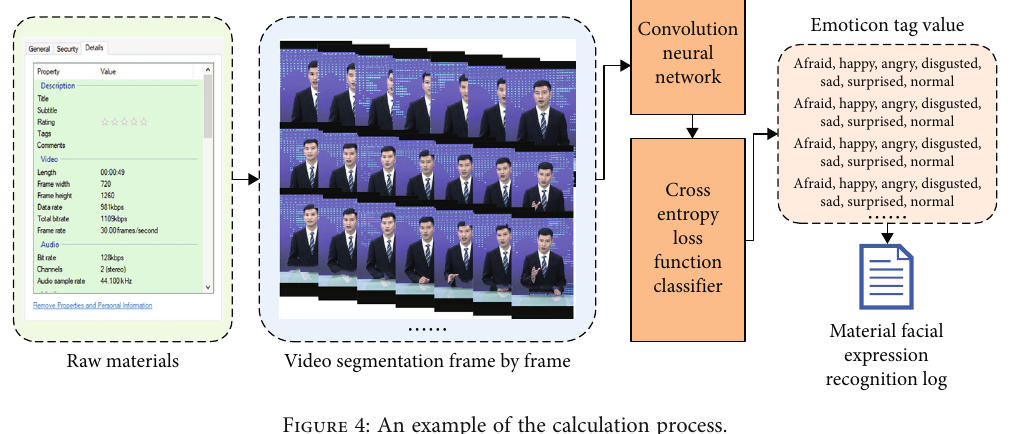
Figure 4: An example of the calculation process.